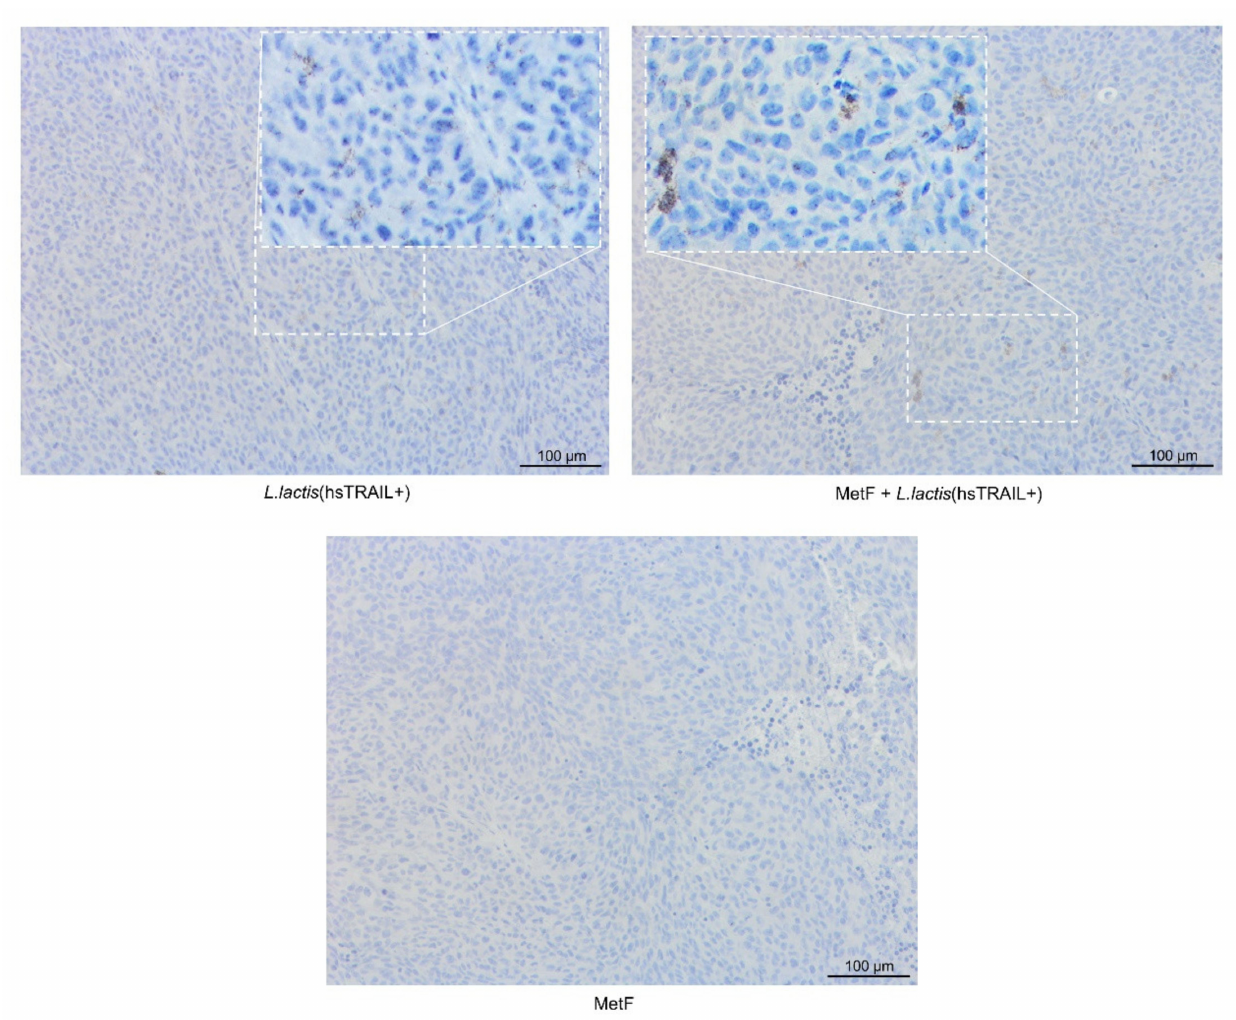
Figure 6. L. lactis (hsTRAIL+) bacteria survival within subcutaneous tumors and intratumor location of hsTRAIL produced by the injected bacteria: ( a ) Subcutaneous tumors were excised, homogenized and inoculated on plates containing M17 agar medium with Cm10 as a selection agent. Plasmids isolated from randomly picked bacterial colonies were subjected to PCR analysis, using the primers specific for hsTRAIL-cDNA sequence insert (438 bp; arrow); ( b )Results from electrophoresis of PCR products are shown. Legend: M—size marker (bp); Ctrl+—positive control (details in Materials and Methods); ( c ) IHC staining of tumor sections for hsTRAIL protein. Representative photos of paraffin-embedded slides of tumors subjected to IHC analysis for detection of intratumor presence of human TRAIL are shown (brown spots). Scale bar: 100 µ m. White dashed lines denote areas that were subsequently magnified (200%) and corrected for light intensity, sharpness/crispiness, and contrast (with the same parameters for all magnified areas; for better quality presented also in Figures S5 and